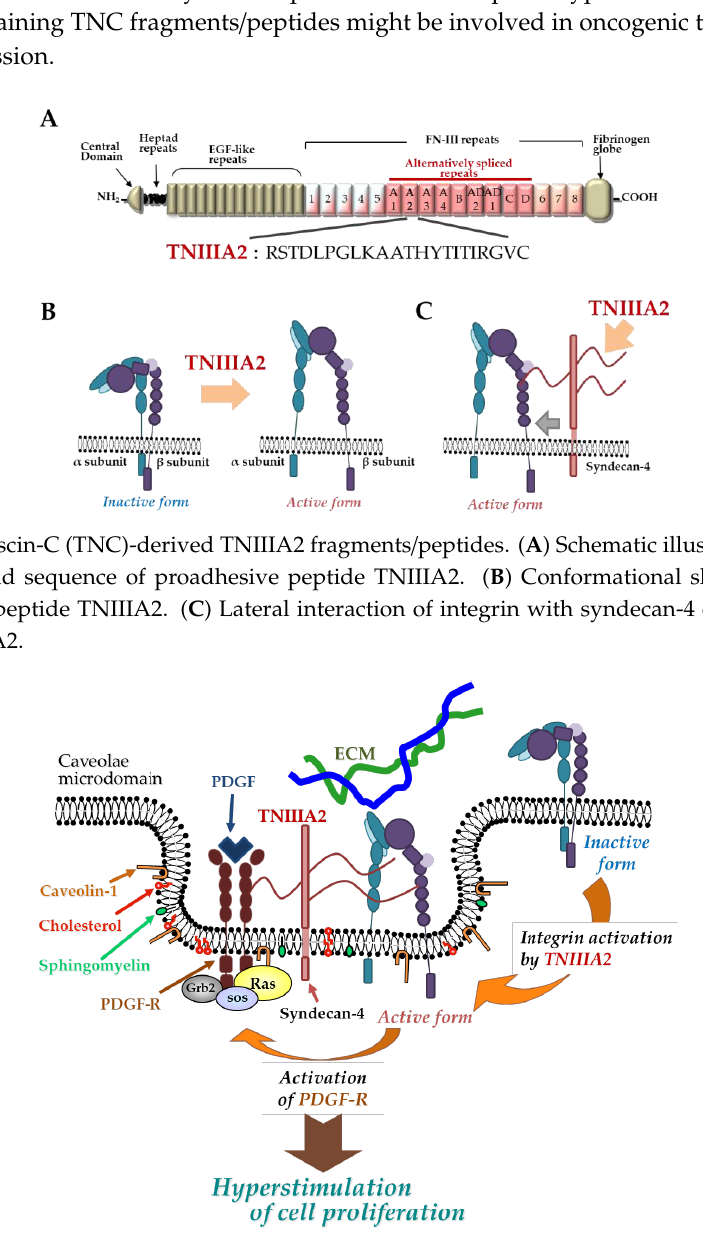
Figure 2. Physical and functional association between TNIIIA2-stimulated integrin α5β1 and PDGF receptor (PDGF-R). Peptide TNIIIA2 induces integrin α5β1 activation through a lateral